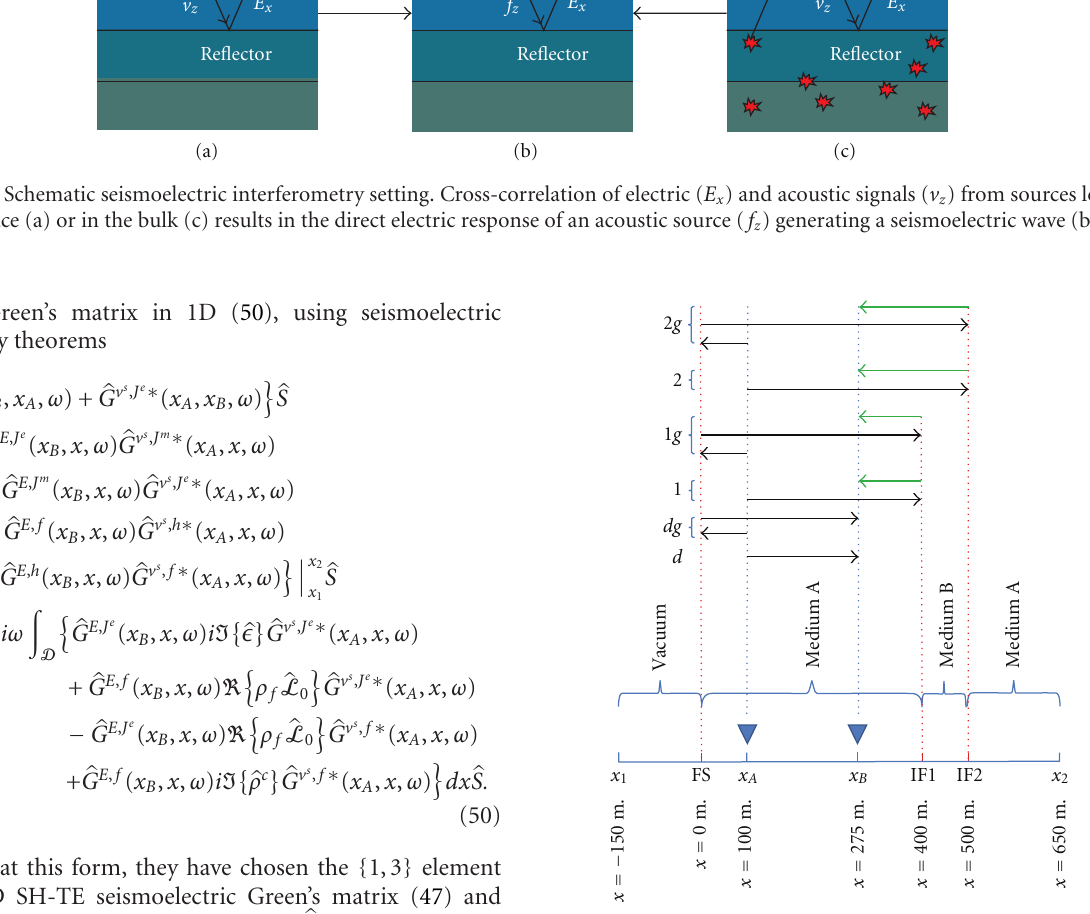
Figure 13: The geometry of the 1D numerical experiment. Posi- tions x A and x B represent the receiver positions, denoted by the top-down triangles. The upper boundary is called x 1 and the lower boundary x 2 , located at x = − 150m and x = 650m, respectively. The positions of the interfaces are visualized by the red bars. FS denotes the free-surface, whereas IF 1 and IF 2 correspond to the first and second subsurface interfaces, respectively. Furthermore, schematic ray paths of events in the seismoelectric Green’s function G E , f ( x B , x A , t ) are shown. The black arrows represent shear wave ray paths, whereas the green arrows depict electromagnetic ray